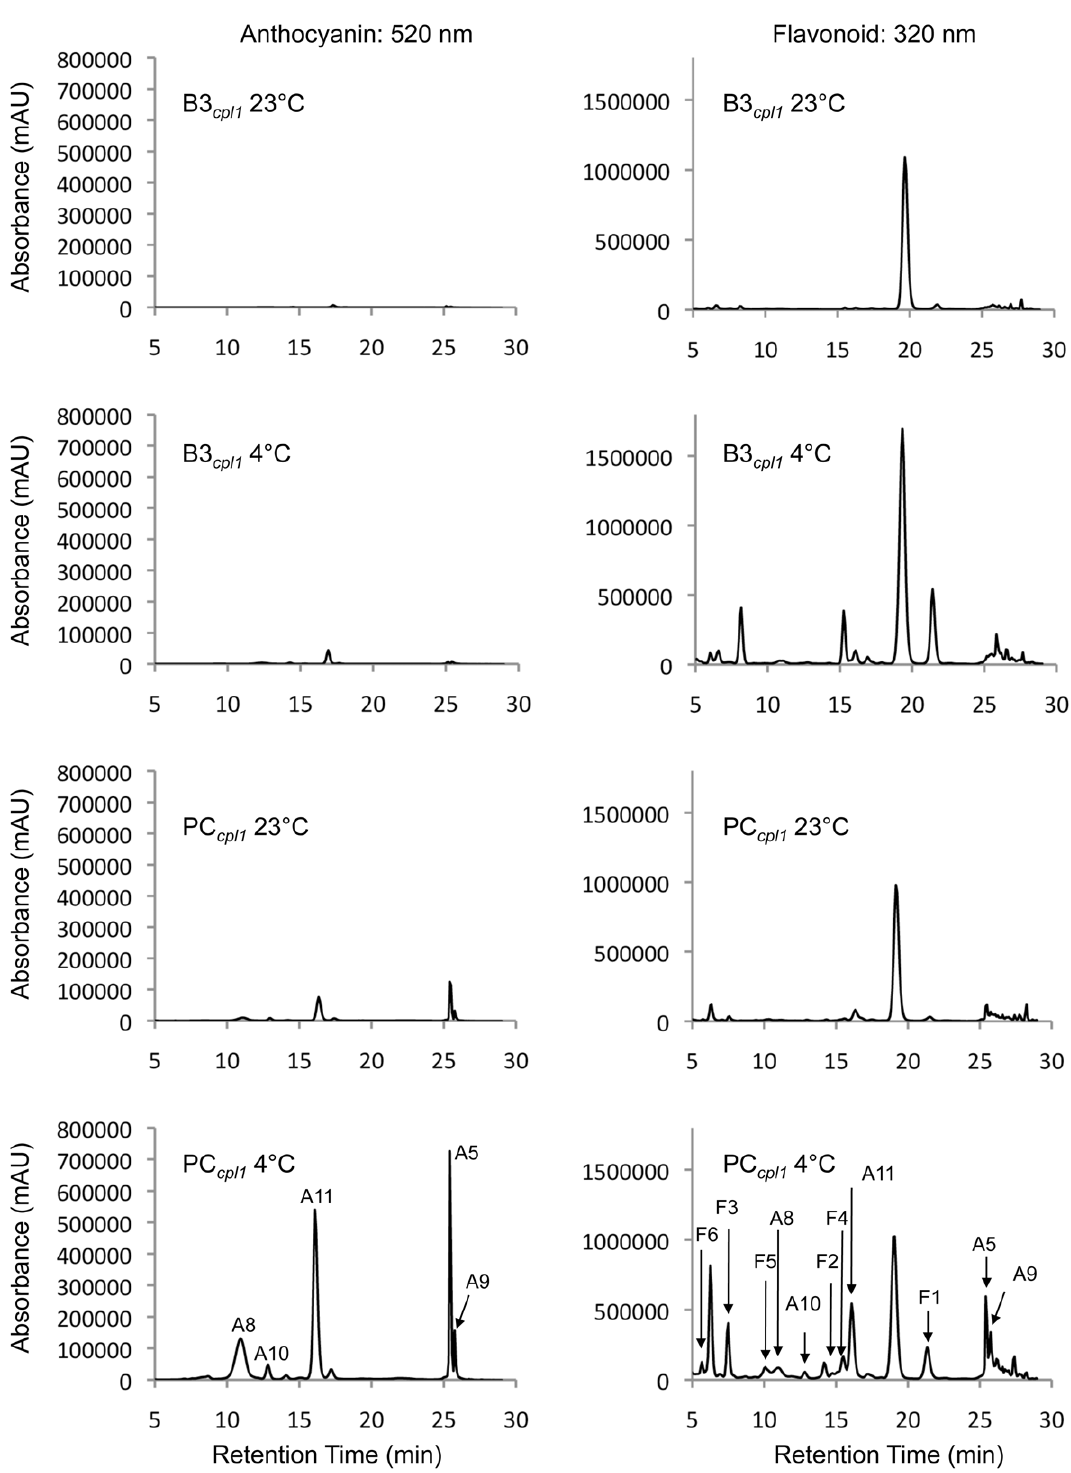
Figure 5. HPLC/PDA chromatograms showing the flavonoid profiles of PC cpl1 and B3 cpl1 plants under normal growth condition (23 6 C) or after additional 3 weeks of cold treatment (4 6 C). ‘‘A’’ stands for cyanidin derivatives, and ‘‘F’’ stands for flavonoids, which were identified by LC-MS. The peaks were labeled according to Tohge et al (2005).